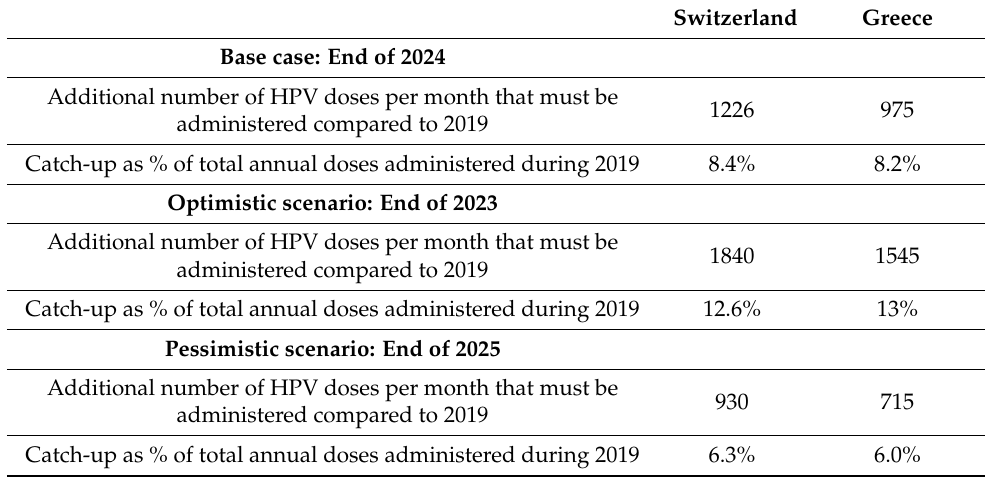
Table 2. Catch-up rates required to clear the cumulative deficit of missed doses by